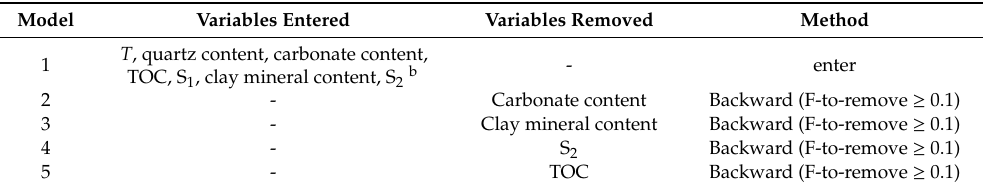
Table 3. Variables entered / removed a